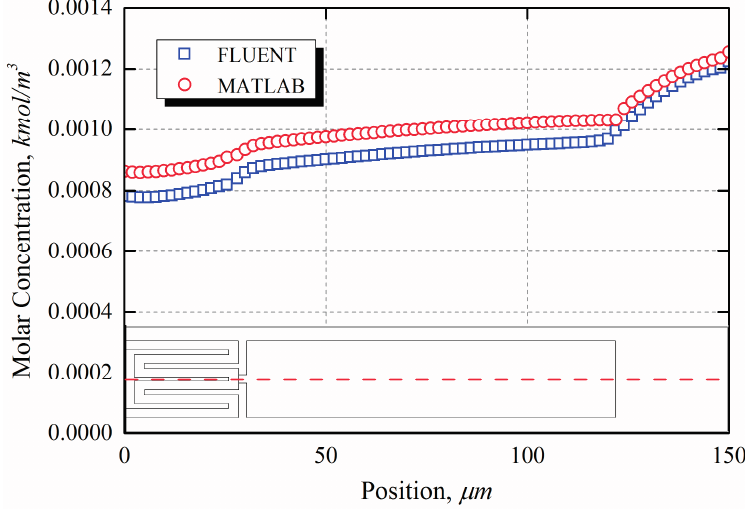
Figure 7. Concentration profiles over the microcantilever surface in the longitudinal